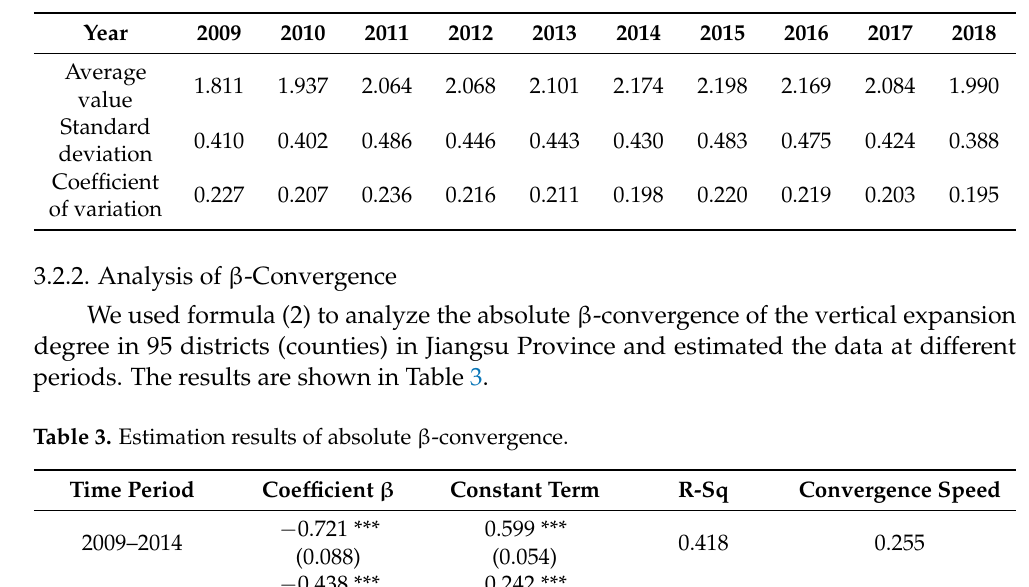
Table 2. The variation coefficient of urban vertical expansion in Jiangsu Province.